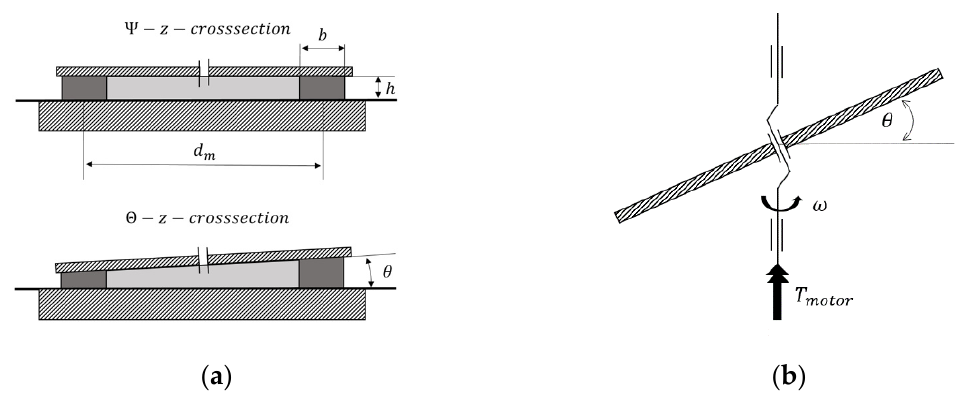
Figure 5. Simplified abstracted model of the pump system: ( a ) wobble plate on top connected with the rubber ring in zero and maximum deflection; ( b ) illustration of the transmission from rotary drive to wobbling plate (the roller bearing allows a rotation between wobble plate and drive shaft, the wobble plate itself is blocked due to the attached and fixed rubber).